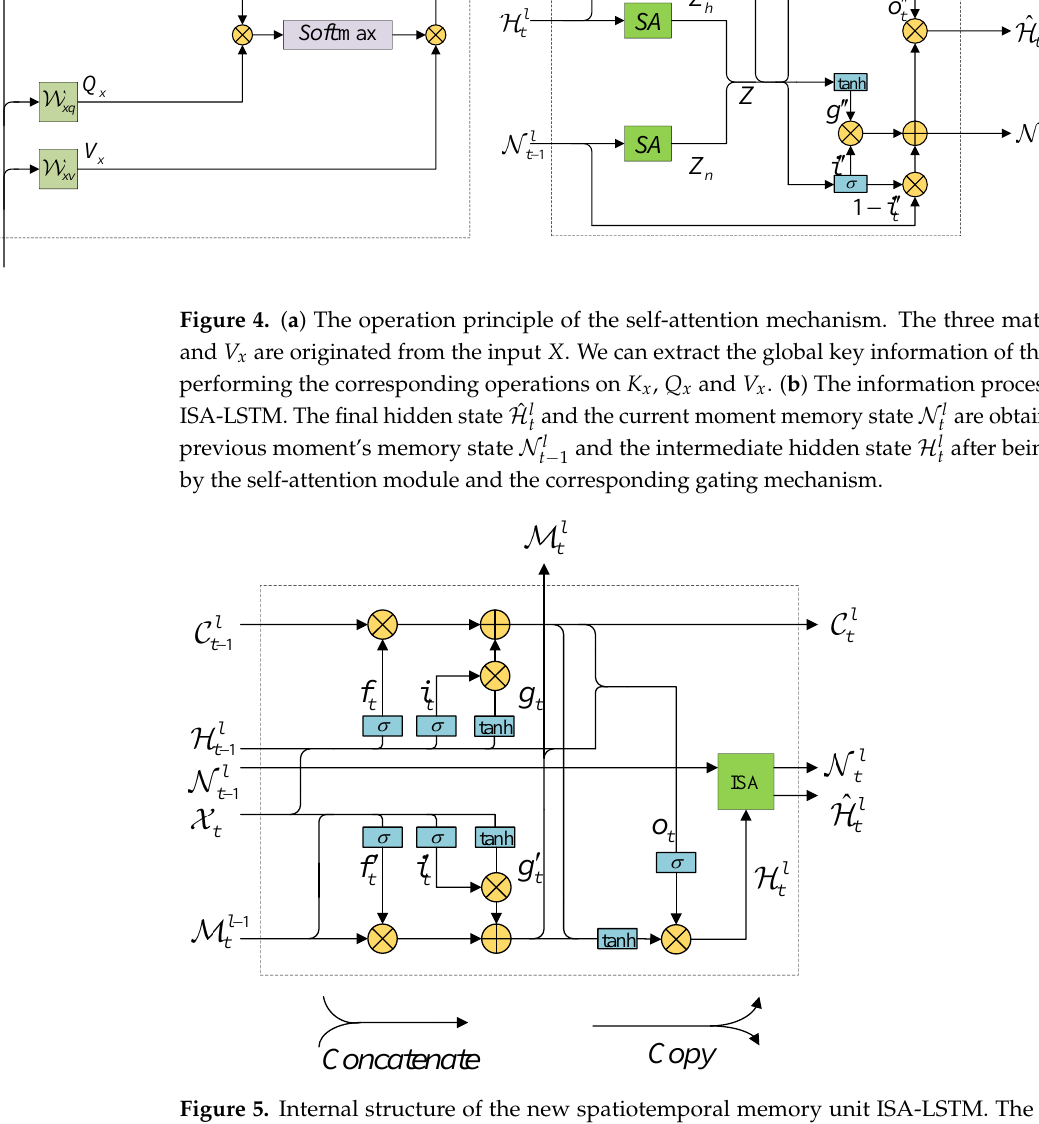
Figure 5. Internal structure of the new spatiotemporal memory unit ISA-LSTM. The ISA module consists of two parts: the self-attention mechanism and the GRU-like update gate. Except for the ISA module, the rest of the ISA-LSTM is the same as the basic structural unit of the PredRNN-V2.